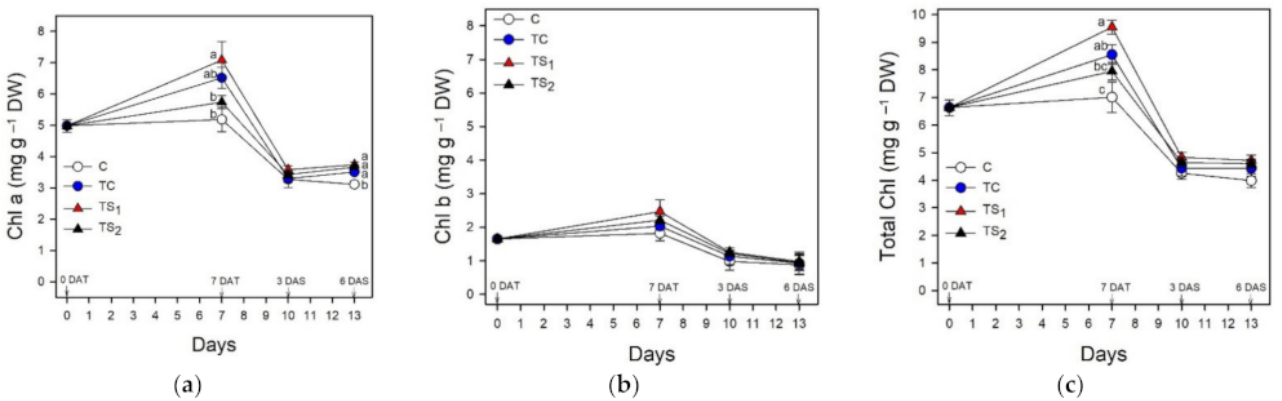
Figure 3. Leaf contents of chlorophylls in purple basil cv. Red Rubin at 0 and 7 days after bacterial treatment (0 DAT and 7 DAT, respectively) and at 3 and 6 days after water stress (3 DAS and 6 DAS, respectively): ( a ) chlorophyll a (Chl a); ( b ) chlorophyll b (Chl b); ( c ) total chlorophyll (total Chl). Values are means ± SE ( n = 3). Different letters indicate significant differences among bacterial treatments and control (one-way ANOVA with Fisher’s LSD test, p ≤